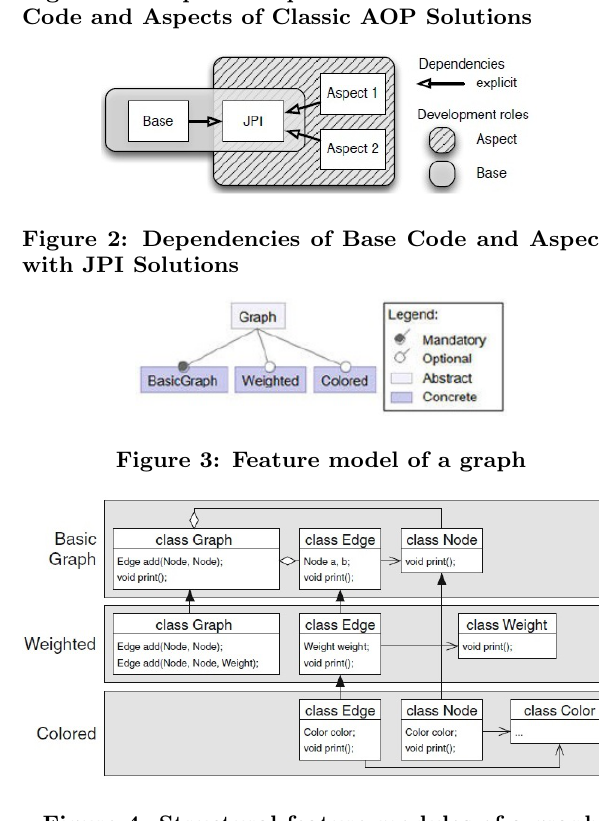
Figure 4: Structural feature modules of a graph